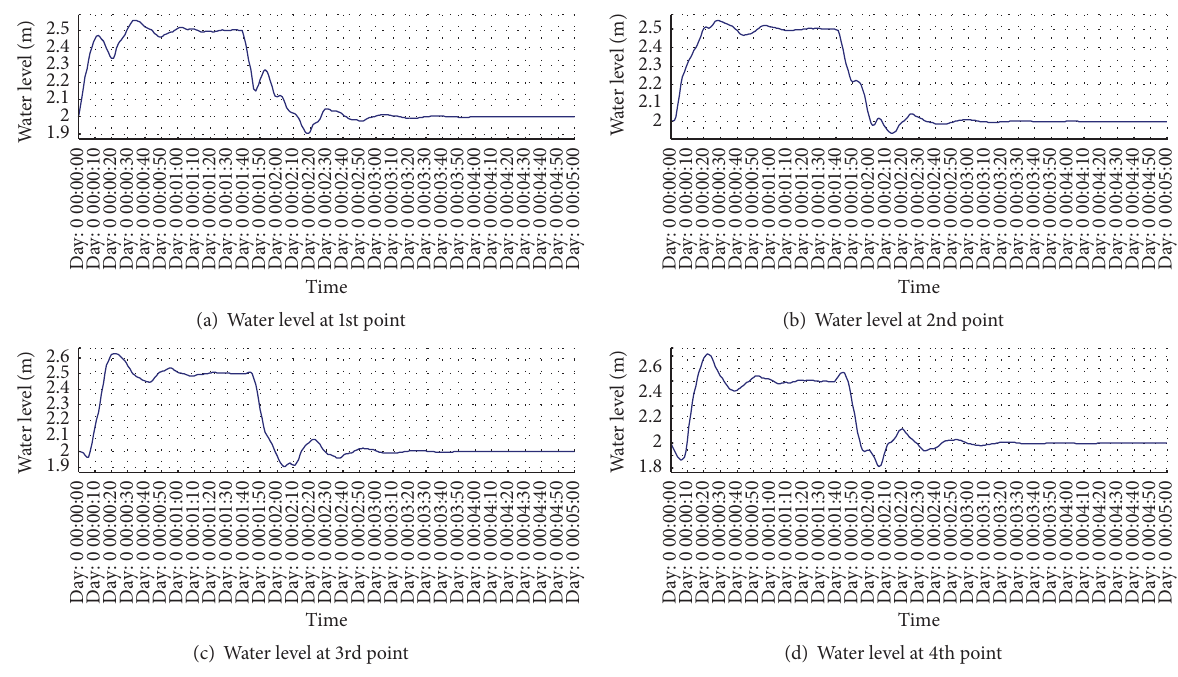
Figure 11: Evolutions of water levels at four points in pool 1 with 𝑁 = 𝑀 = 60 .